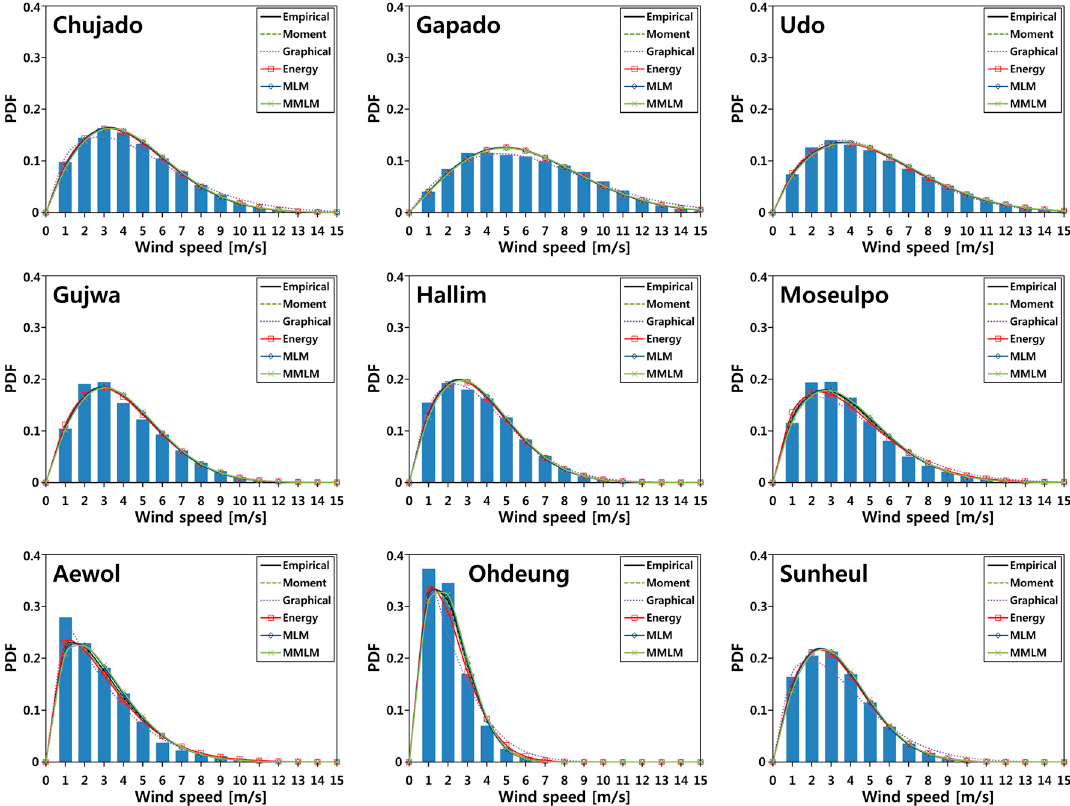
Figure 5. A comparison between the observed wind speed distributions and estimated Weibull PDFs.